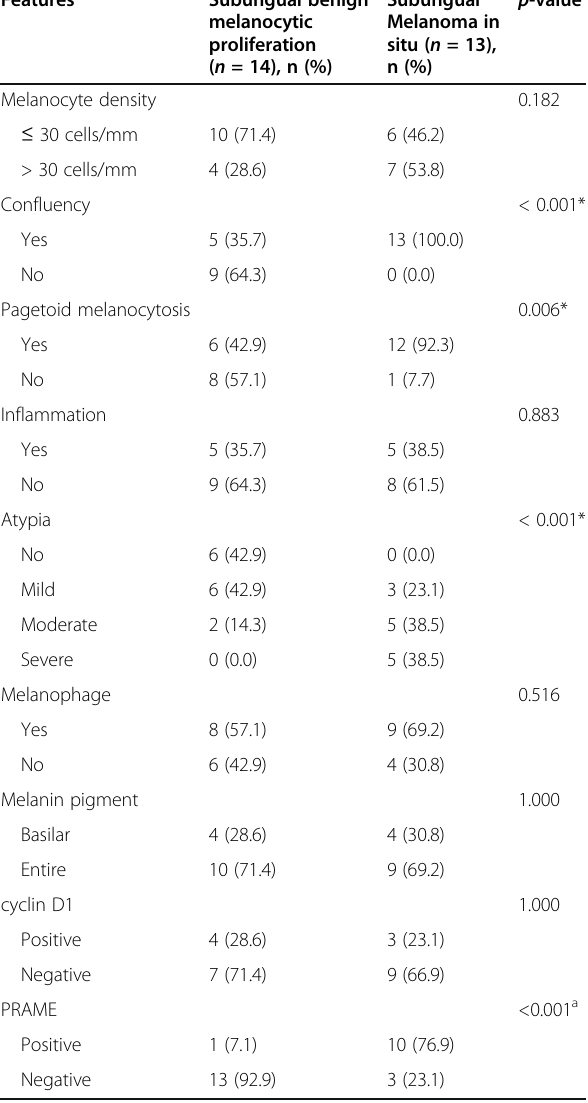
Table 2 Histopathological features of subungual benign melanocytic proliferation and subungual melanoma in